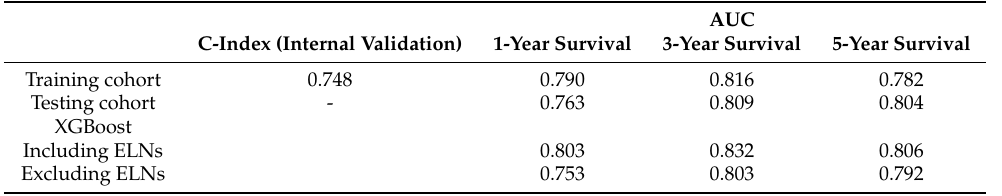
Figure 4. The area under the receiver operating characteristic curve (AUROC) of the model in pre- dicting 1-, 3-, and 5-year overall survival (OS) in the training cohort ( a ) and 1-, 3-, and 5-year OS in the validation cohort ( b ).